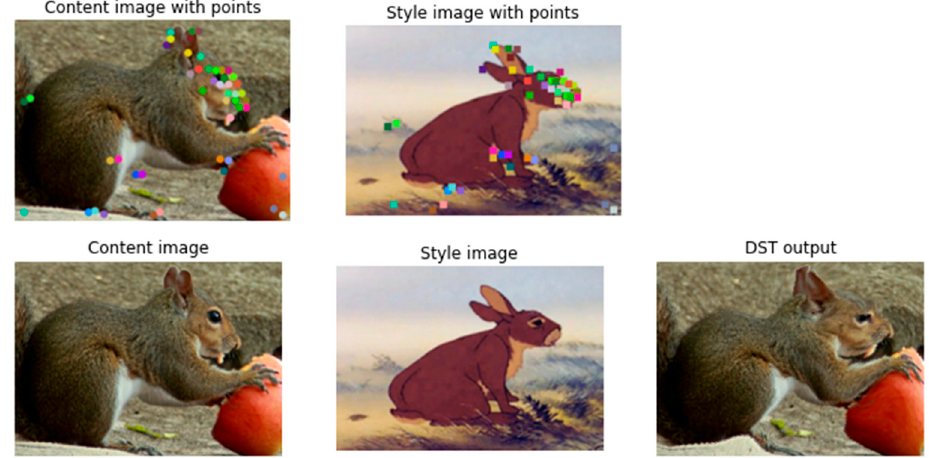
Figure 9. Results on two images whose features and alignment do not match.